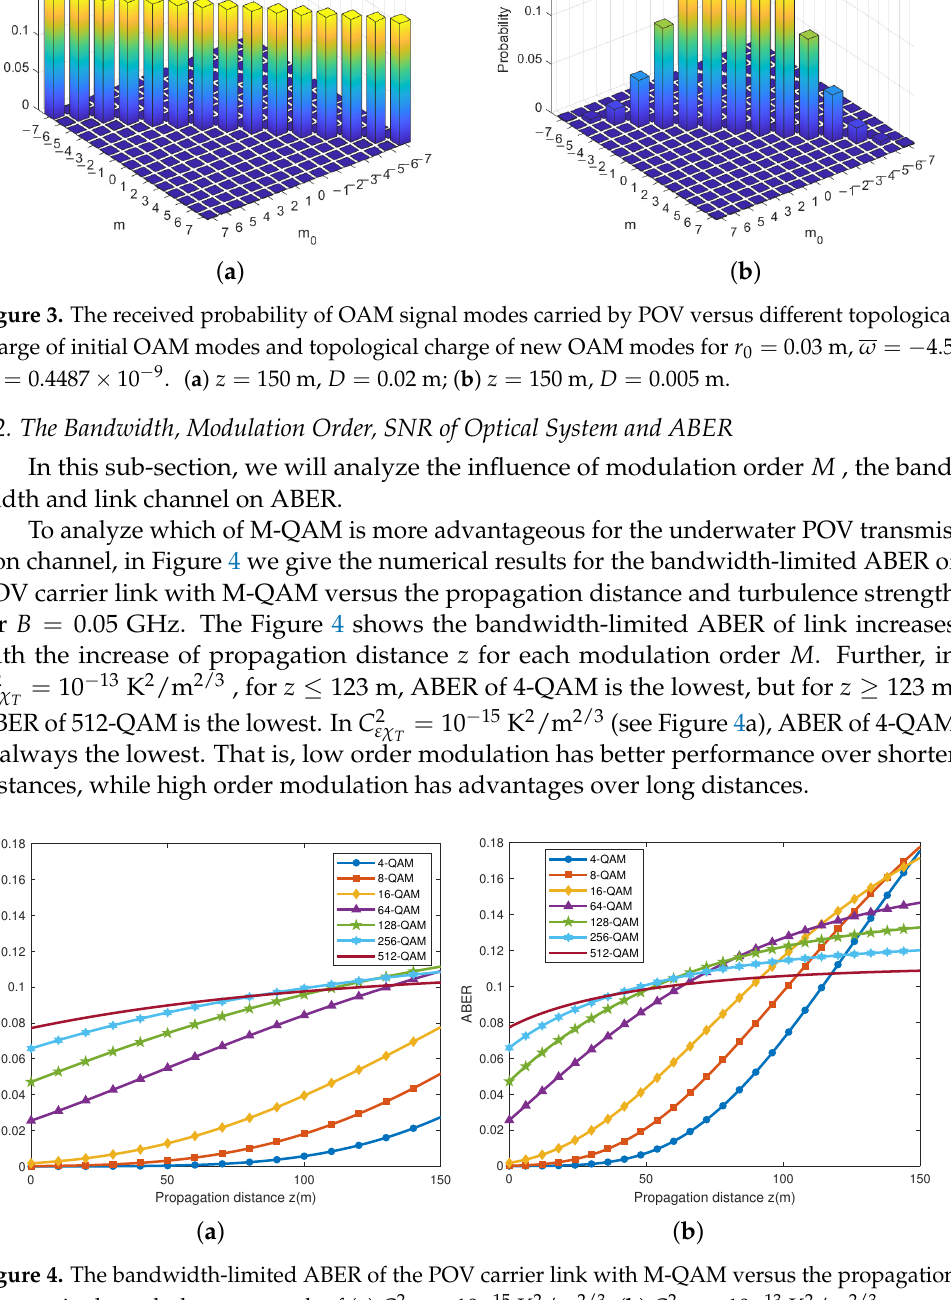
= 10 − 15 K 2 /m 2/3 , ( b ) C 2 = 10 − 13 K 2 /m 2/3 εχ T T